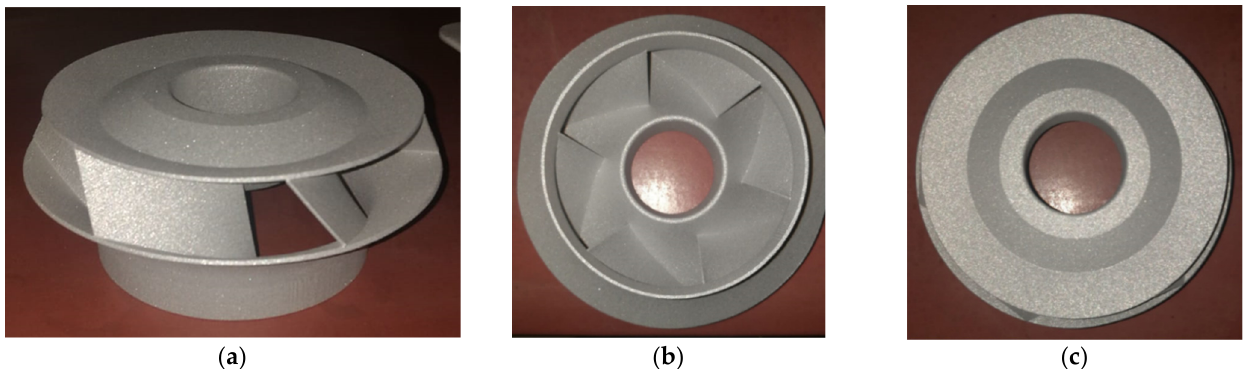
Figure 11. Functional model of the impeller printed through the SLM technology by the service ZARE S.r.l.: ( a ) 3D view, ( b ) bottom view, and ( c ) top view.